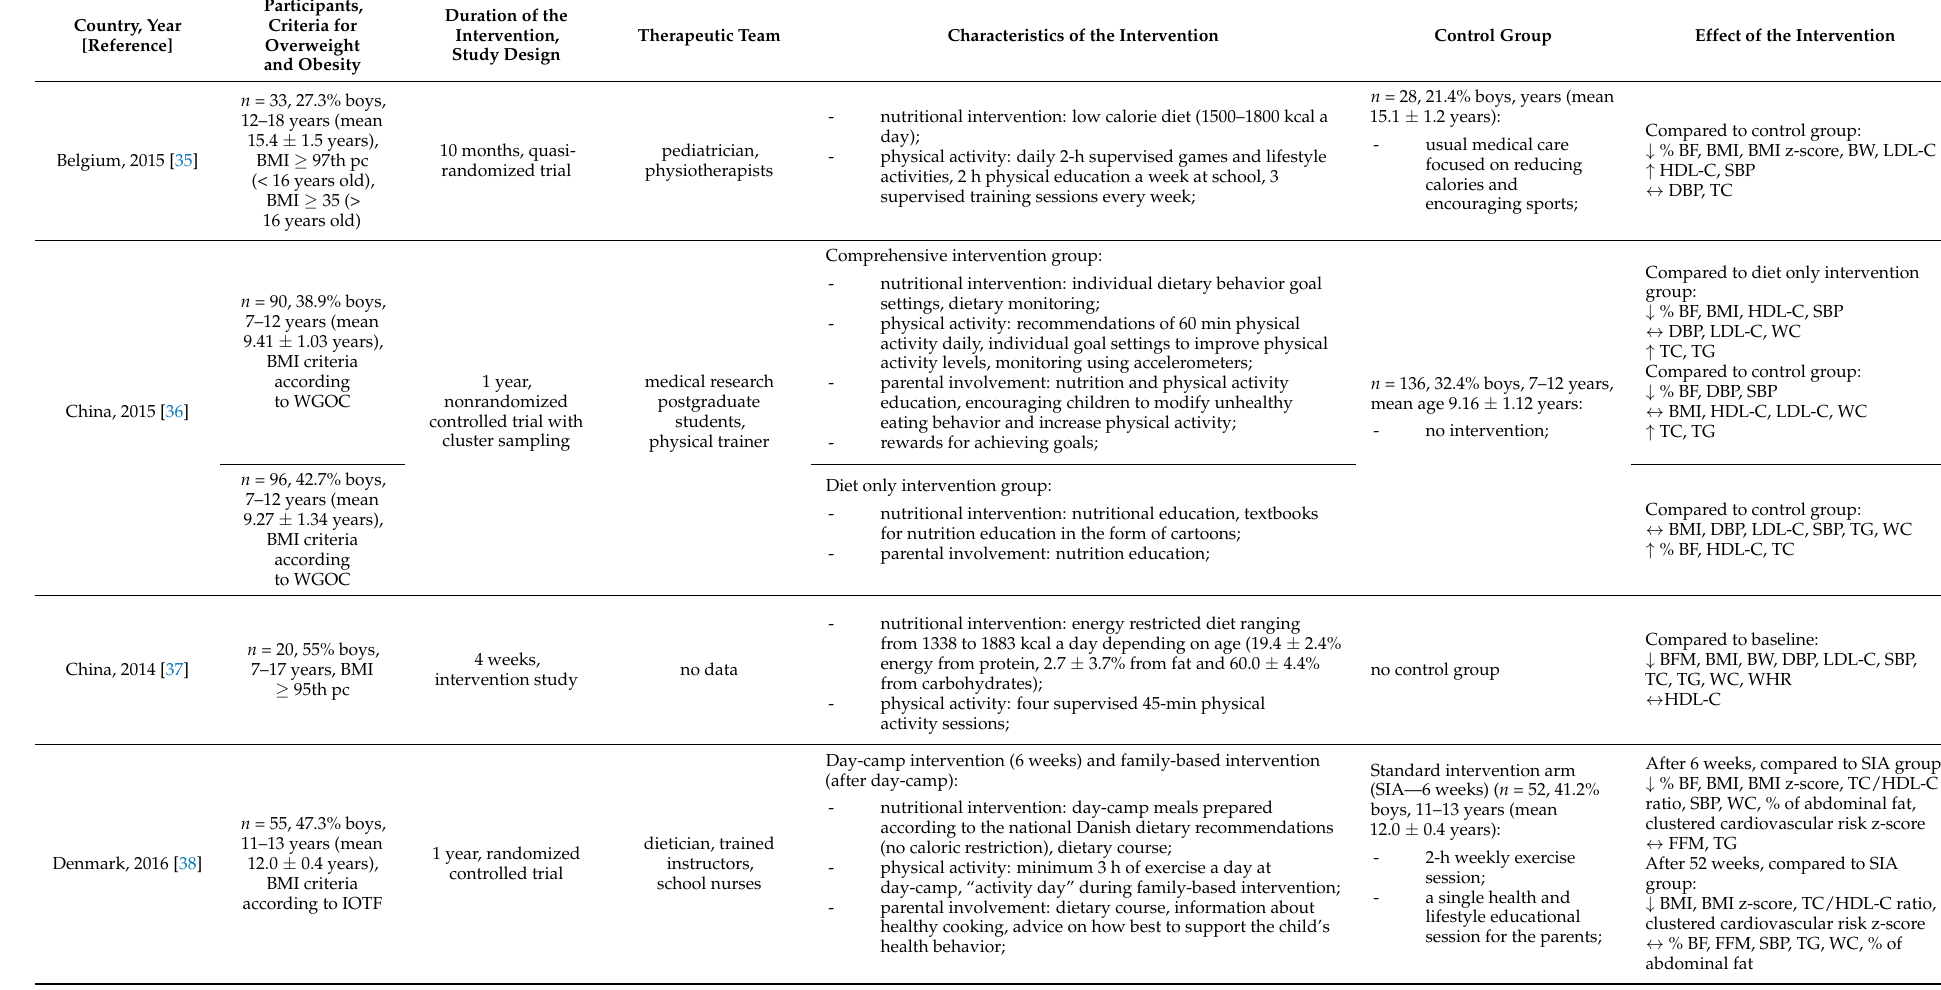
Table 2. Characteristics of the lifestyle intervention studies in children and adolescents with overweight or